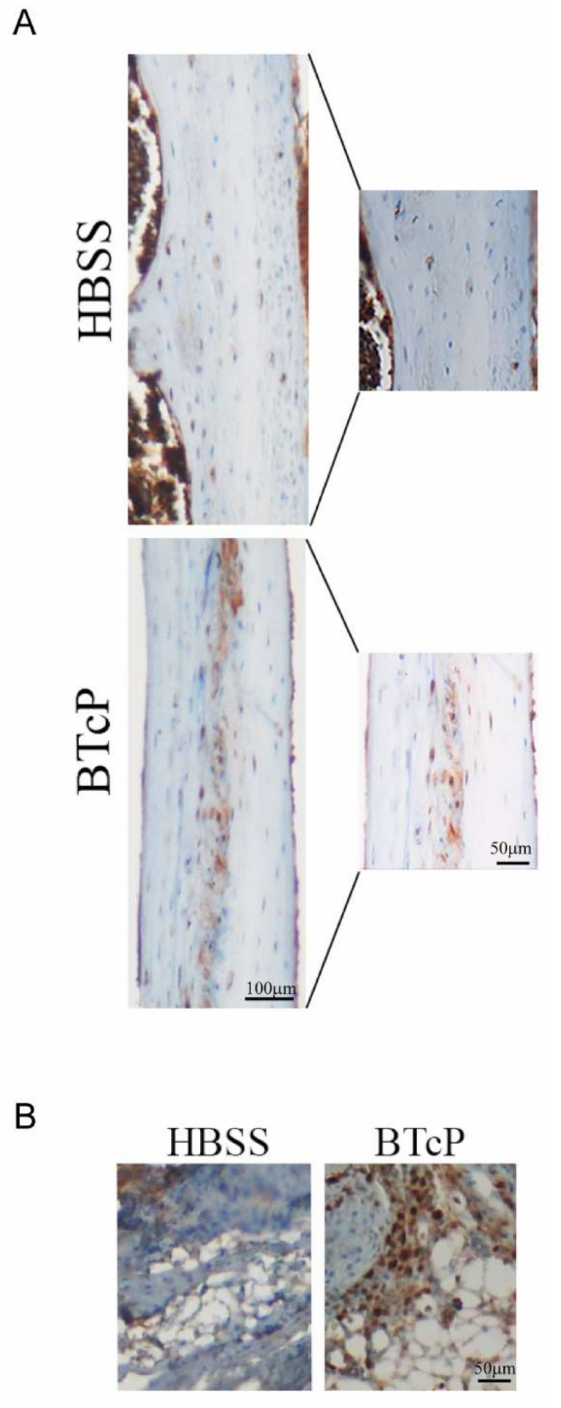
Figure 1. Proliferating cancer lung cells in the femur of BTcP mice. Cytokeratine immunostaining in representative tissue sections from the femur of control mice locally injected with HBSS and mice injected with LLC cells (BTcP mice) is shown in ( A ). Ki-67 immunostaining is shown in ( B